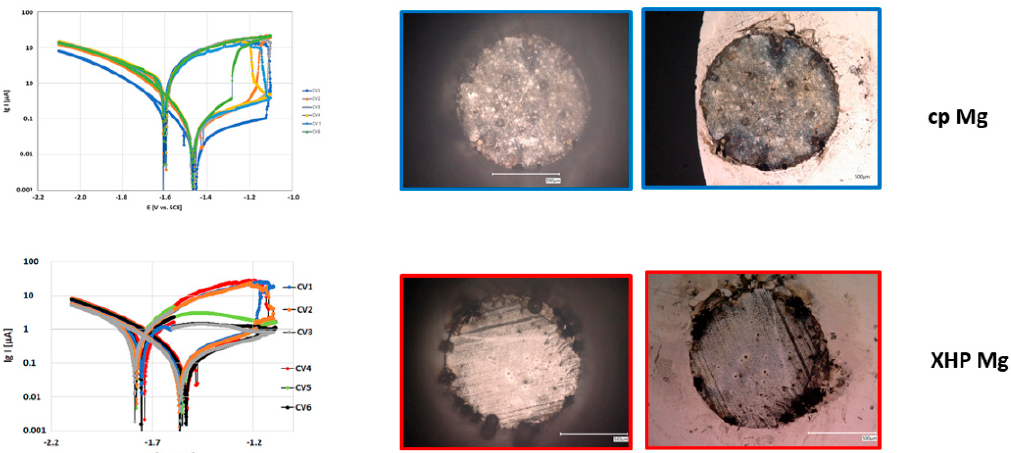
Figure 8. Left: lgi vs. E curves, cycle 1 and 6; right: microscopic view onto the surface after cyclic loading, ( left ) immediately after polarization and ( right ) after drying the surface. The upper row shows the CVs and microscopic pictures for cp Mg and the lower row for XHP Mg. Table 3. Electrochemical measurement results, static conditions.